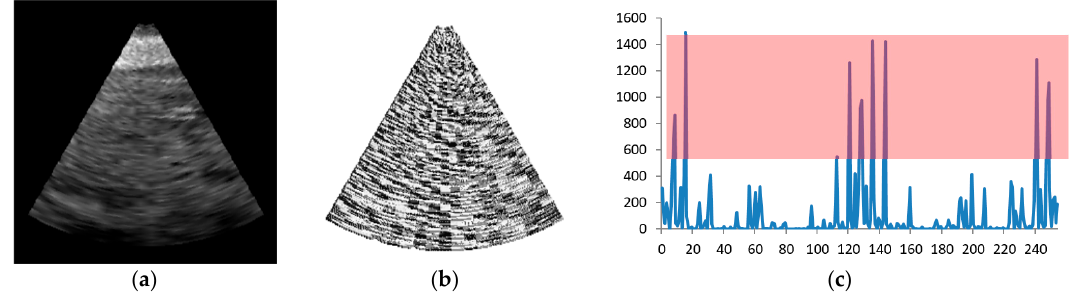
Figure 10. ( a ) A synthetic ultrasound image; ( b ) The LBP image; ( c ) the LBP histogram.